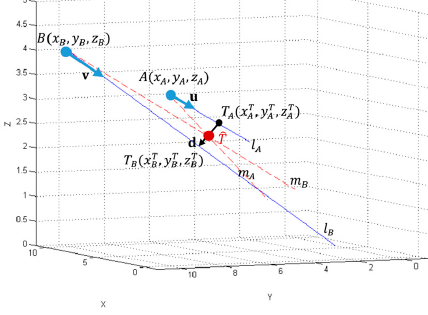
Figure 3. Extrapolation of localization point from the distance of the askew lines.